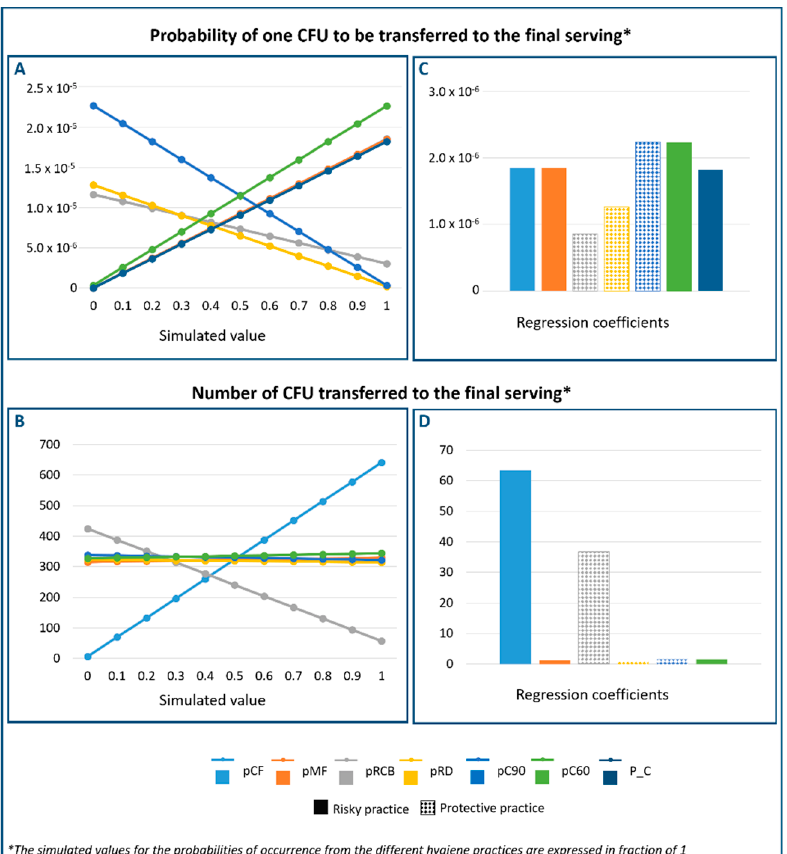
Figure 5. ( A ) Probability of one CFU of ESBL-/AmpC-producing E. coli being transferred and ( B ) the number of CFU transferred to the final serving as a function of the hygiene practices. Regression coefficients between the probabilities of action occurrence and the probability of one CFU being transferred to the final serving ( C ), and the number of CFU transferred to the final serving ( D ), including their protective or risky effect on consumer exposure. (i) probability that the raw